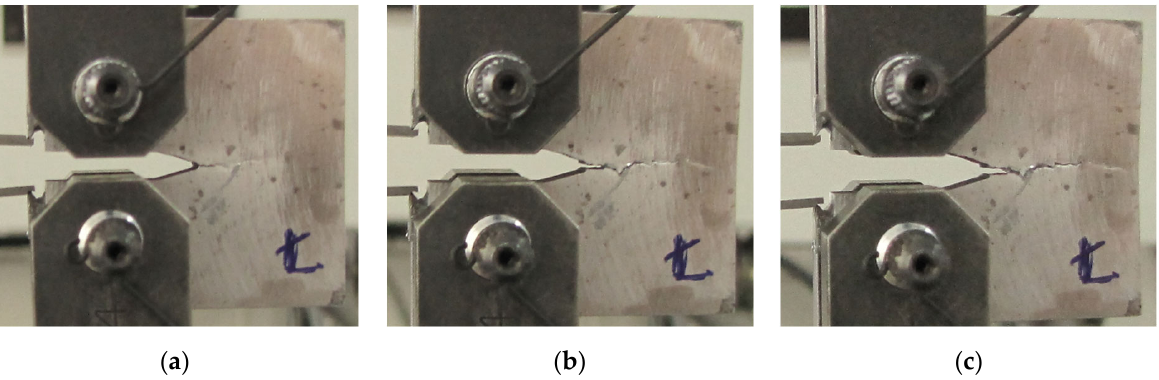
Figure 3. CT mini ‐ specimen made of 44200 aluminium alloy with 15% Al 2 O 3 reinforcement under monotonic tension: ( a ) the initial stage; ( b , c ) the stages before fracture.